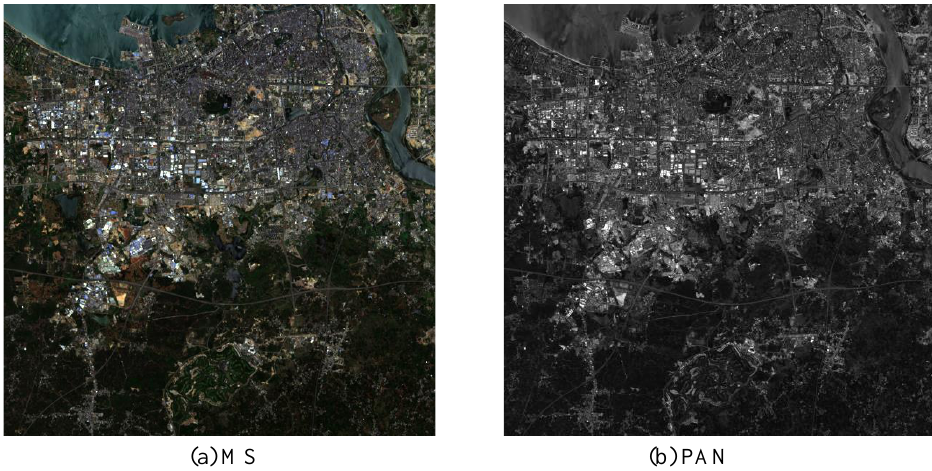
Figure 9. Training datasets of Landsat-8 near the South Bay in Haikou City, Hainan Province. ( a ) MS image with 30 m spatial resolution; ( b ) PAN image with 15 m spatial